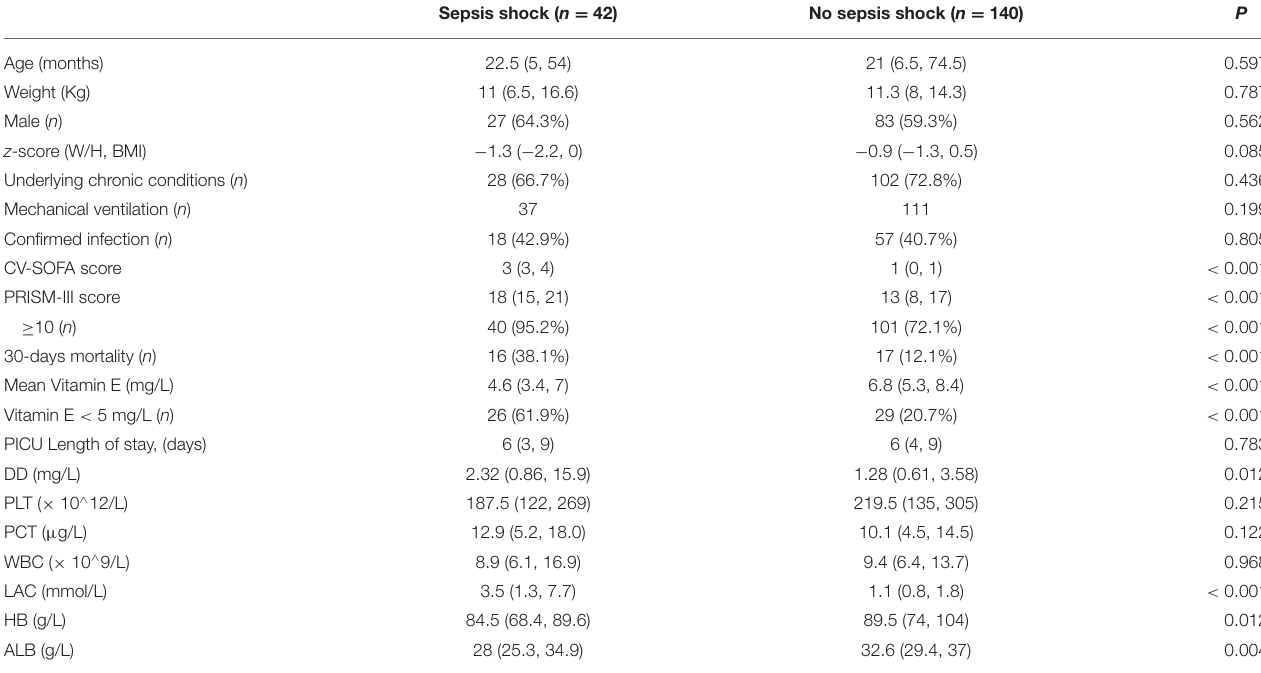
TABLE 3 | Comparison of septic and non-septic shock